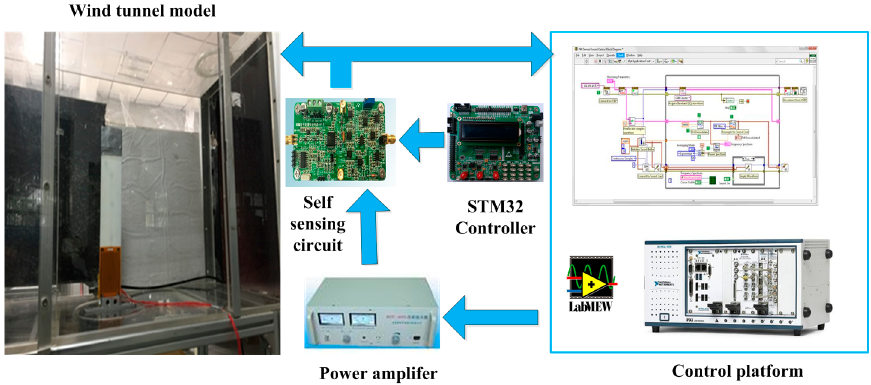
Figure 9. Frequency response function of bridge unbalance circuit ( a ) with no compensation, and ( b ) with feedforward compensation.